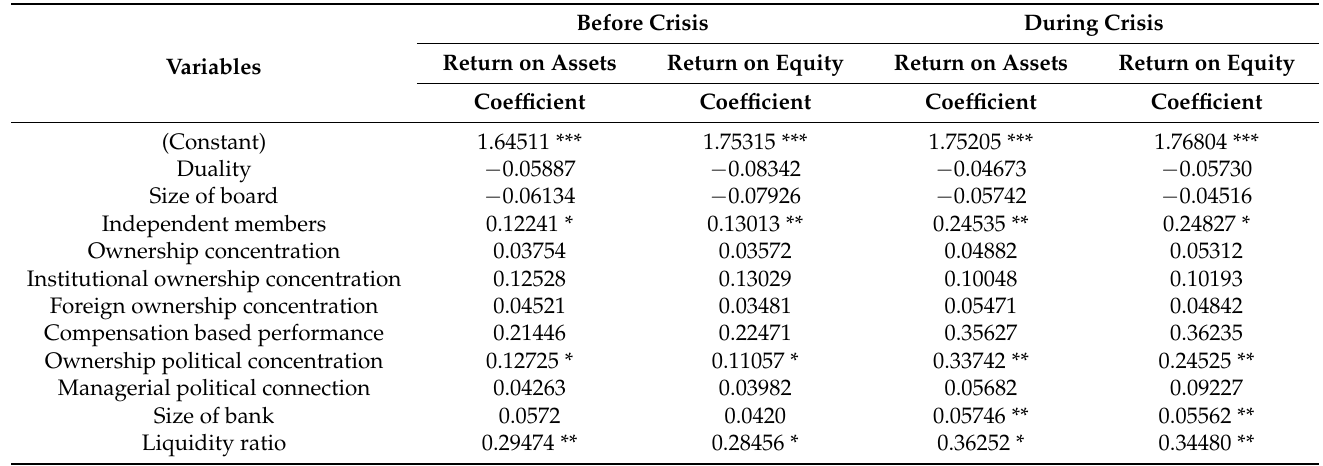
Table 5. OLS Regressions of ROA and ROE on Corporate Governance Variables, and